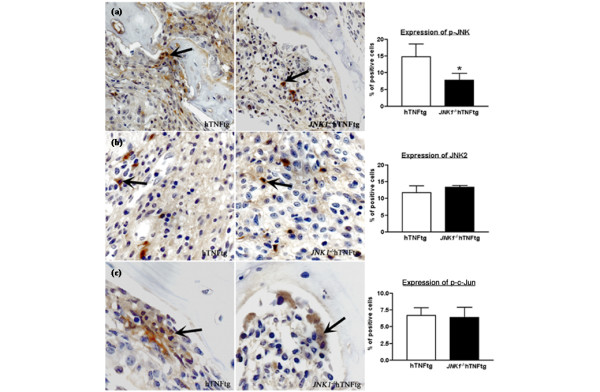
Analysis of JNK activation in human tumour necrosis factor transgenic (hTNFtg) and JNK1-/-/hTNFtg mice. Synovial inflammatory tissue of the mice were stained with antibodies against the phosphorylated form of JNK (a), total JNK2 (b), and the phosphorylated forms of c-Jun (c). Positive cells are stained in brown (arrows; magnification 400×). Results of quantification (percentages of positive cells) are given in separate bar charts. Vertical bars indicate standard deviation. JNK, c-Jun N-terminal kinase; p-c-Jun, phosphorylated c-Jun; p-JNK, phosphorylated JNK. 1 cm = (a) 40 μm, (b, c) 30 μm.